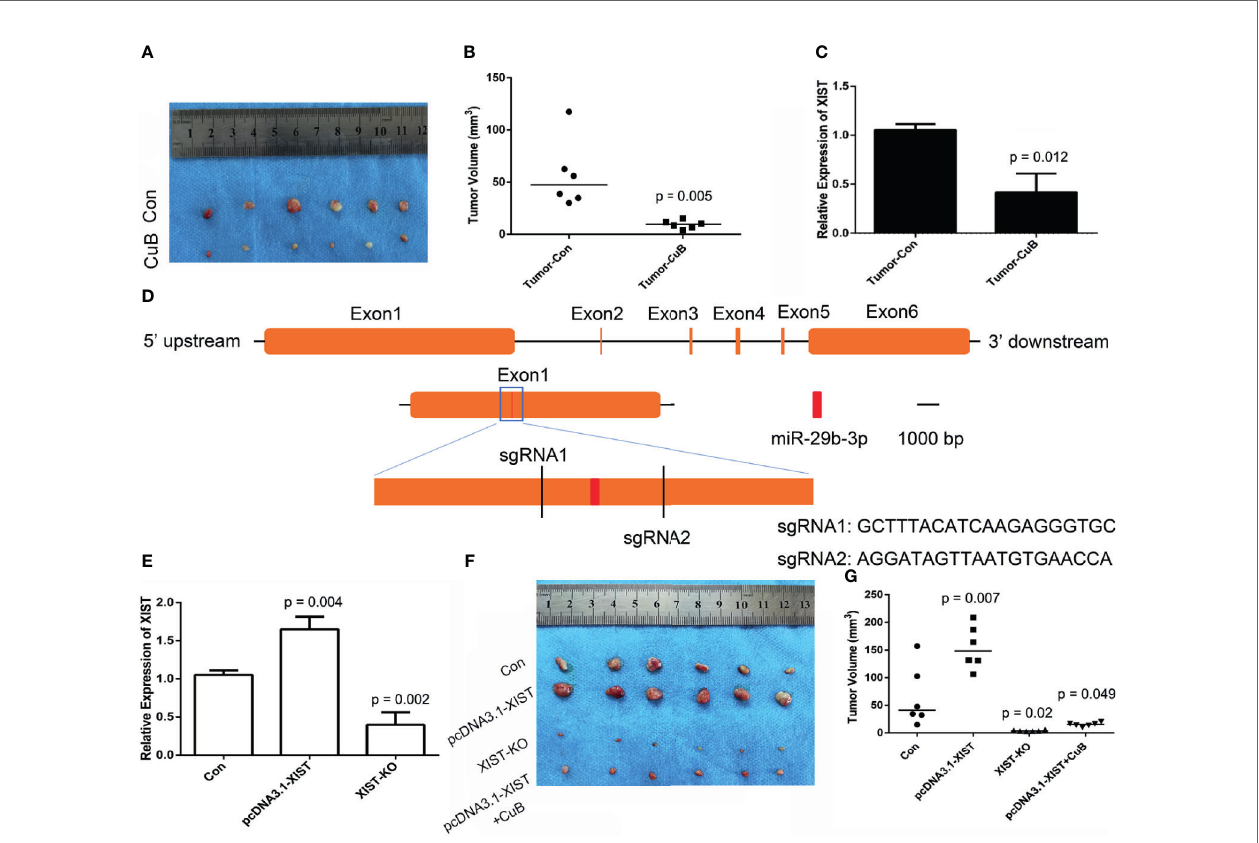
FIGURE 8 | CRISPR/Cas9-mediated gene targeting of XIST . (A) Morphological observation of the mouse TSCC tumor tissue (N = 6 in each group). (B) Analysis of tumor volume. (C) Expression pattern of XIST in mice tumors after CuB treatment. Data are represented as mean ± SD (n = 3). (D) Schematic diagram of sgRNAs targeting the XIST gene loci. (E) Expression of XIST using qPCR in SCC9 cells. Data are represented as mean ± SD (n = 3). (F) Tumor morphology and (G) volume (N = 6 in each group). Statistical signi fi cances between groups were evaluated using t-test for independent groups. Yellow indicates XIST , while red indicates exon of